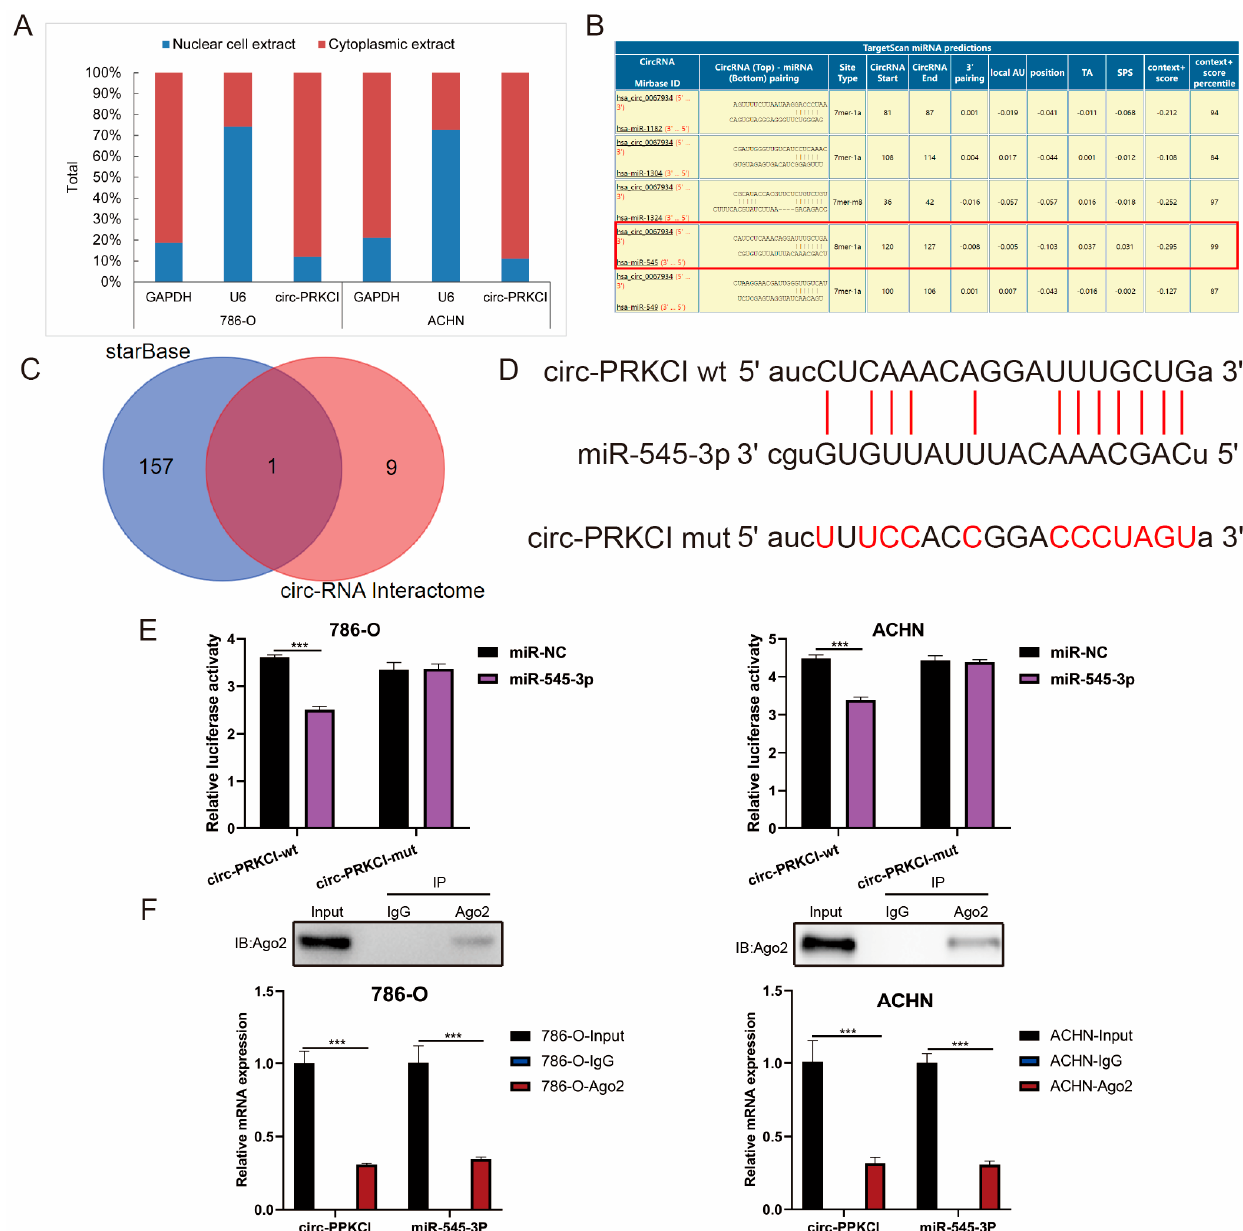
Figure 5. circ-PRKCI could serve as a sponge for miR-545-3p. ( A ) The subcellular distribution of circ-PRKCI in RCC cells, as detected by subcellular fraction assay. ( B ) The potential miRNAs linked to circ-PRKCI (circBase ID: hsa_circ_0067934) via online bioinformatics database Circular RNA Interactome, the selected hsa-miR-545 was highlighted within red frame. ( C ) A Venn diagram of the potential miRNAs linked to circ-PRKCI between Circular RNA Interactome and StarBase 3.0 database. ( D ) Schematic representation of the 3 ′ -UTR of circ-PRKCI with the predicted target site for miR-545-3p. ( E ) The binging ability between miR-545-3p and circ-PRKCI was certified by Luciferase reporter assay. ( F ) An RIP assay was used to confirm the combination between miR-545-3p and circ-PRKCI. Top, Western blot results of IP efficiency of Ago2-antibody. Bottom, relative RNA expression compared with input. IgG served as a negative control. (*** p < 0.001).